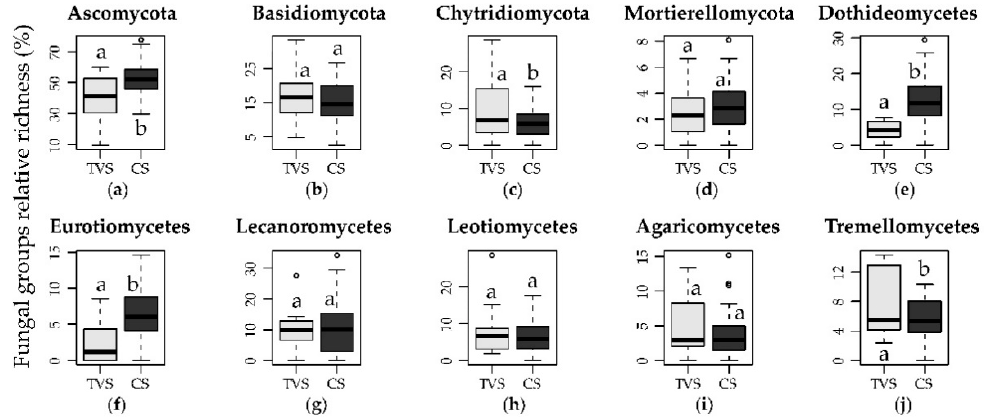
Figure 4. Differences in the relative richness of the most abundant fungal phyla ( a – d ) and classes ( e – j ) in the two different environments (TVS: Taylor Valley sites; CS: coastal sites).